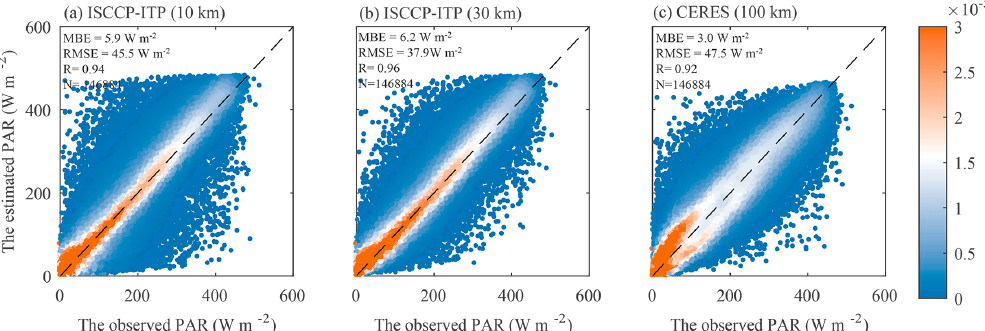
Figure 3. Comparisons of our estimated instantaneous PAR product (ISCCP-ITP) at spatial resolutions of (a) 10km, (b) 30km, and (c) hourly PAR of the CERES SYN1deg (edition 4.1) with observed PAR collected at 42 NEON stations.